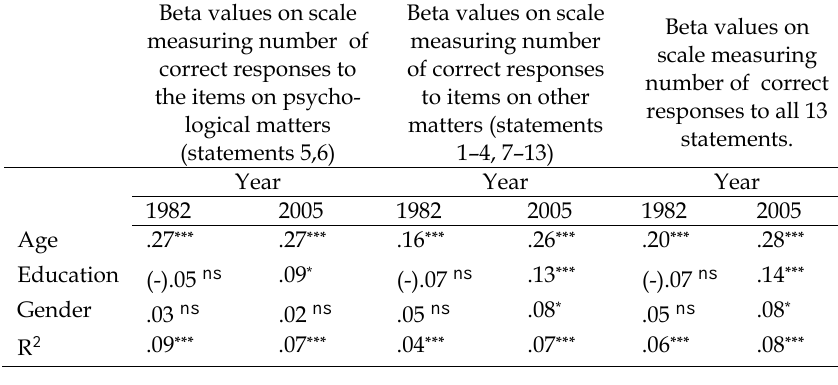
Table 5 . Relative importance of age and education to knowledge accord- ing to MCA